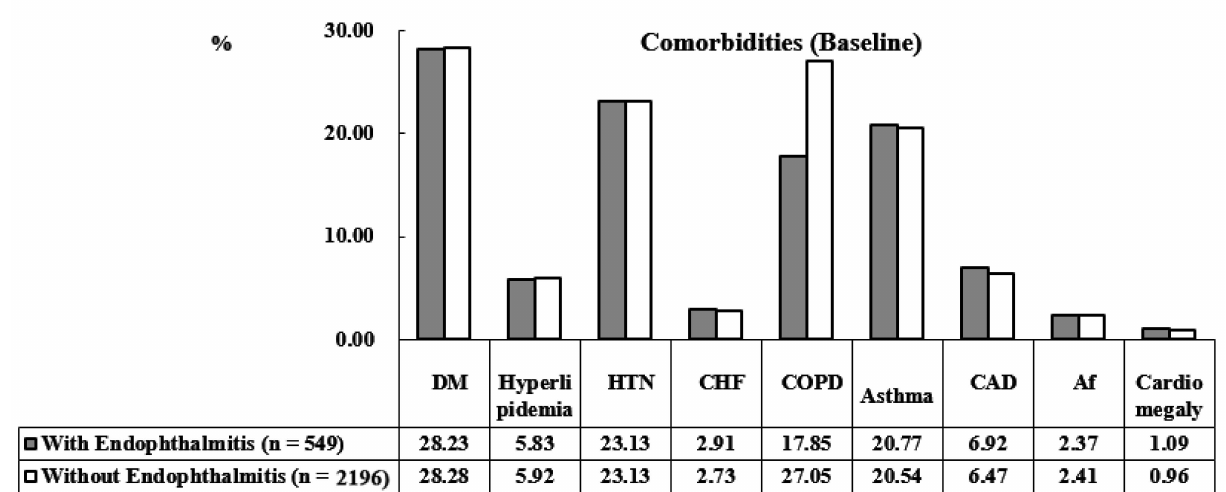
Figure 2. Bar graph of the comorbidities in the study population at baseline.